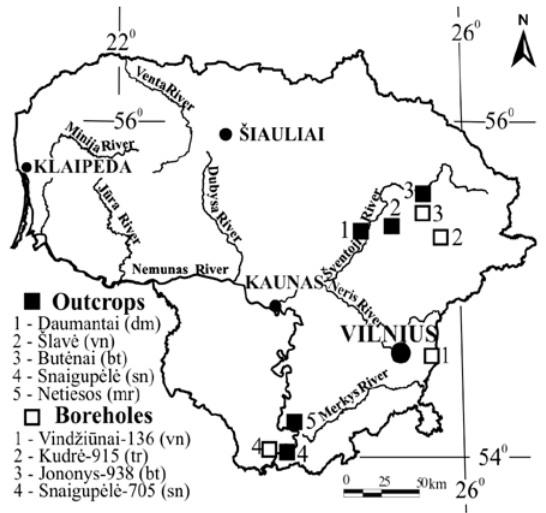
Fig. 2. Location of study objects of interglacial sediments Notes: Interglacials: dm – Daumantai, vn – Vindžiūnai, tr – Turgeliai, bt – Butėnai, sn – Snaigupėlė, mr – Merkinė. Sampled depth intervals (in parentheses) of vertical sections: Daumantai (2.2–19.2 m), Vindžiūnai-136 (146–160 m), Šlavė (2.4–4.8 m),